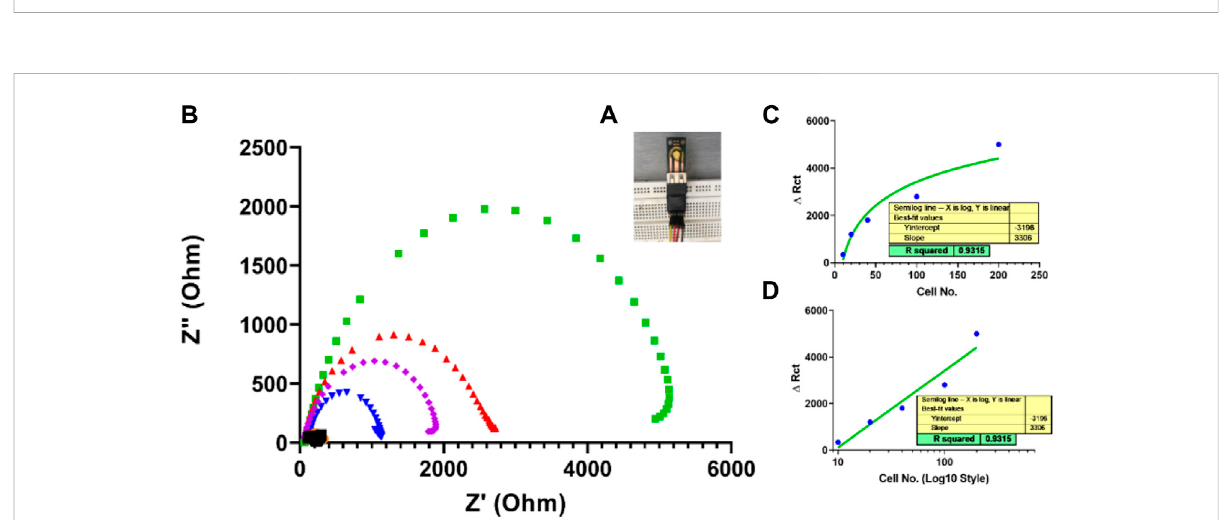
FIGURE 11 (A) A simple impedimetric immunosensorbased on lab-made SPEs. (B) Electrochemical impedance measurements for three samples basedon SPEs EIS response of Herceptin-modi fi ed thin- fi lm gold SPEs toward different SKBR3 cell concentrations (10, cells mL − 1 ) in PBS with 0.5 mM